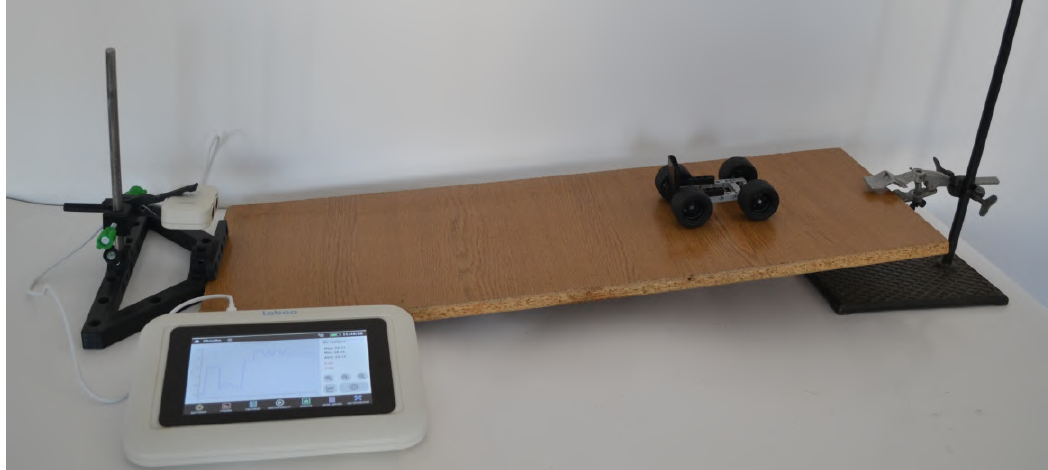
Figure 3: Experimental setup to study the characteristics of body motion on an inclined